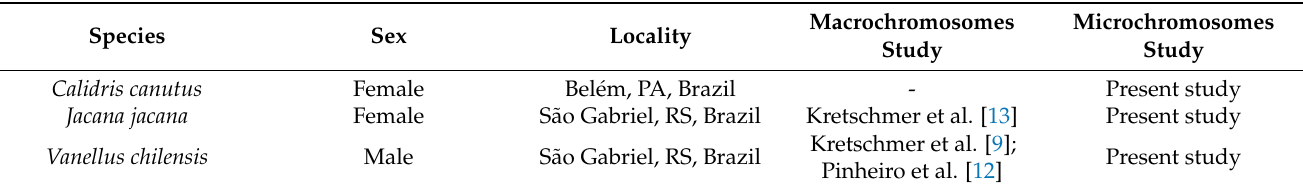
Table 1. List of the avian species investigated and the approaches used. Brazilian States: RS, Rio Grande do Sul; PA, Par á